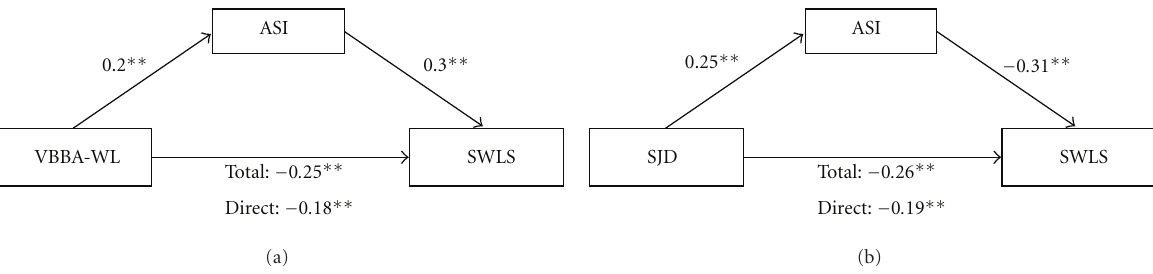
Figure 2: Path models for life satisfaction. Note. VBBA-WL: workload, SJD: specific job demands, ASI: insomnia, SWLS: life satisfaction. more sleep problems, for example, inadequate sleep time or insomnia